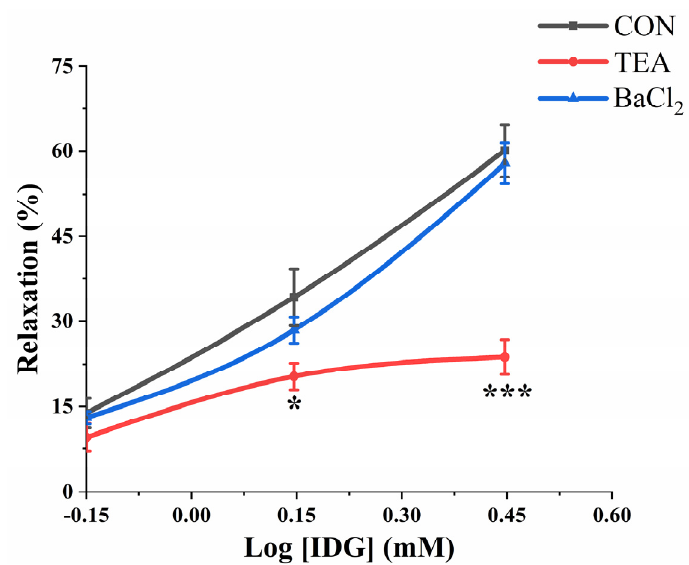
Figure 7. Evaluation of the IDG vasodilatation mechanism associated with K + channels. Vasorelaxant effects of IDG (0.7, 1.4, or 2.8 mM) in NE-pre-contracted endothelium-denuded aorta rings with or without tetraethylammonium (TEA, 1 mM), a blocker of the Ca 2+ -activated K + channel, or BaCl 2 (10 μ M), a blocker of the inward-rectifier K + channel. The half maximal effective concentration (EC 50 )was determined using non-linear regression and a repeated-measures two-way ANOVA to compare curves; n = 6. Note: * p < 0.05, *** p < 0.001 vs. CON.